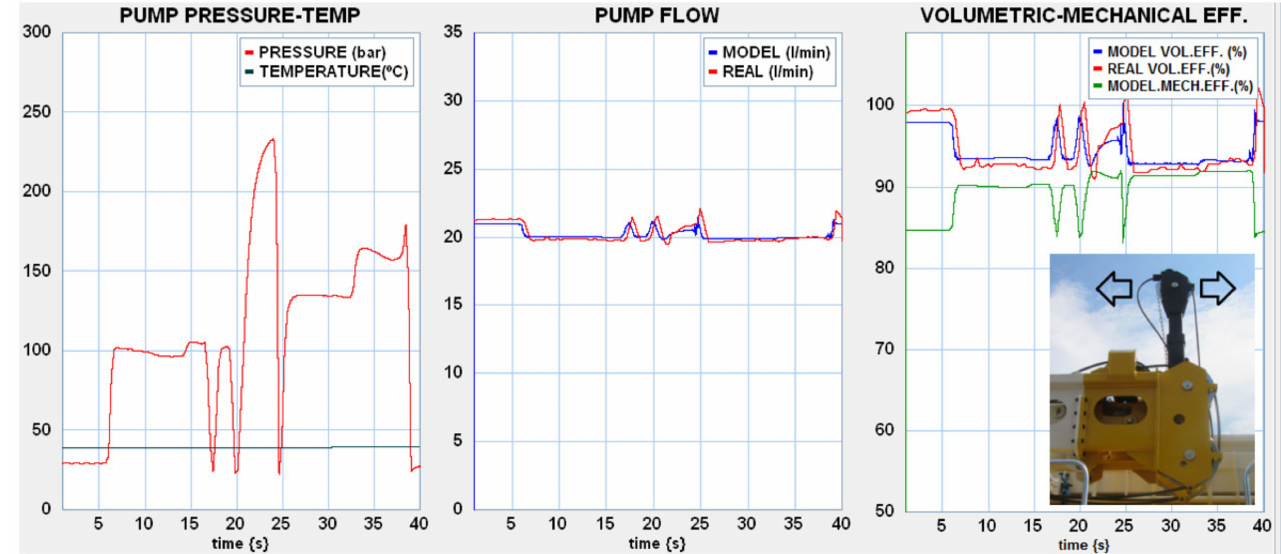
Figure 13. Real and simulated behavior in a jib-raising and -lowering cycle (1467